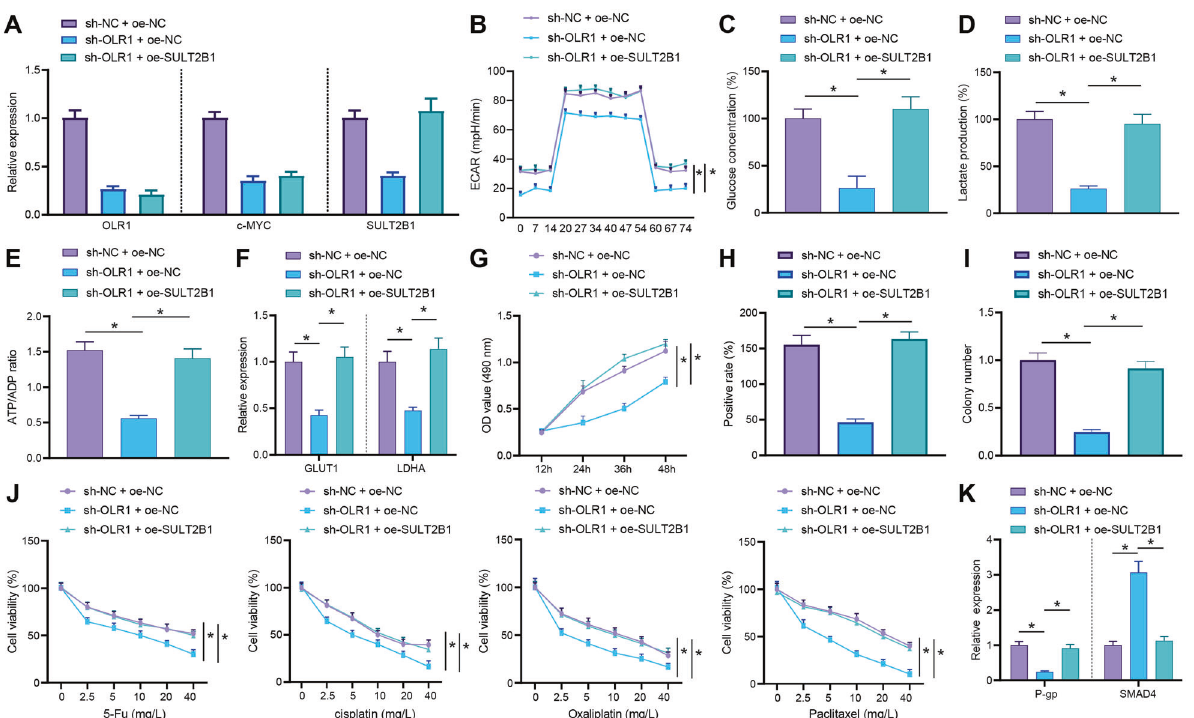
Fig. 6 Blockade of OLR1 /c-MYC/SULT2B1 axis reduces glycolytic metabolism to restrain proliferation and chemoresistance of colon cancer cells. Colon cancer cells were transfected with sh-NC + oe-NC, sh- OLR1 + oe-NC, or sh- OLR1 + oe-SULT2B1. A The mRNA expression of OLR1 , c-MYC, and SULT2B1 in colon cancer cells checked by RT-qPCR. B ECAR of colon cancer cells. C Glucose content in colon cancer cells. D Lactate production in colon cancer cells. E The ATP/ADP in colon cancer cells. F RT-qPCR to detect the mRNA expression of GLUT1 and LDHA in colon cancer cells. G The proliferation level of colon cancer cells estimated using MTS. H Detection of colon cancer cell clone formation. I The mRNA expression of Ki67 detected by RT-qPCR. Colon cancer cells were transfected with sh-NC + oe-NC, sh- OLR1 + oe-NC, or sh- OLR1 + oe-SULT2B1, followed by treatment with DDP, oxaliplatin, 5-Fu, and paclitaxel. J The drug resistance of colon cancer cells to DDP, oxaliplatin, 5-Fu, and paclitaxel assessed by MTS. K The expression of P-gp and SMAD4 in colon cancer cells tested by RT-qPCR. The cell experiment was repeated three times. * p < 0.05 between two